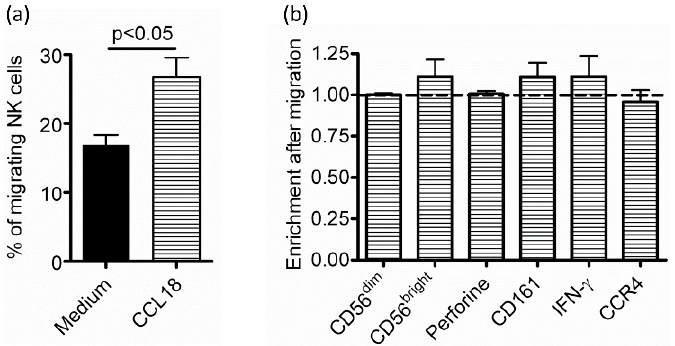
Figure 2. Phenotype of CCL18-recruited NK cells. After overnight culture, the phenotype of NK cells from nonallergic donors ( n = 6) was analyzed before and after migration towards medium or CCL18 in Transwells. ( a ) Percentage of migrating NK cells. ( b ) With the same donors, enrichment of NK cells in the CD56 dim CD16 + , CD56 bright CD16 − , perforine + , CD161 + , IFN- γ + , CCR4 + subsets. Stippled line represents enrichment equal to 1, meaning that the proportion of the NK cell subset was identical before and after migration, which indicates an absence of